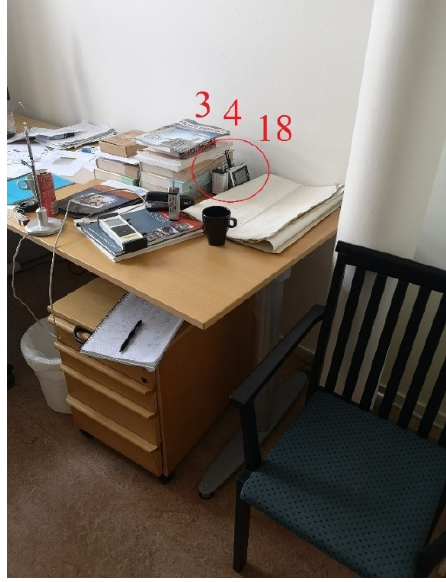
Figure 9. Placement of loggers 3, 4, and 18 in Room B.